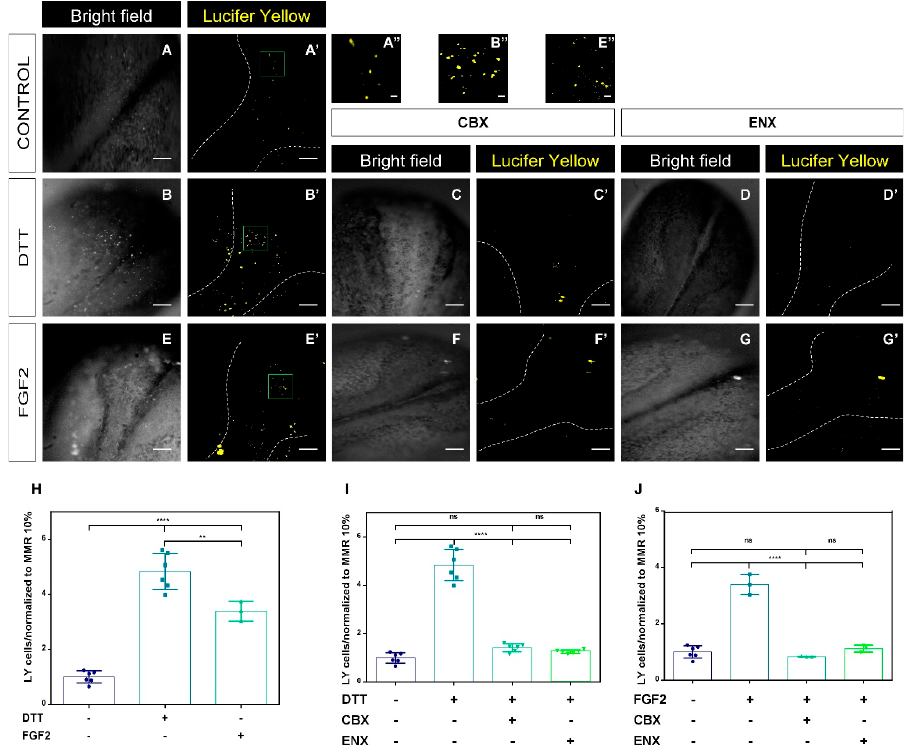
Figure 3. Lucifer Yellow uptake is modulated by FGF2 and DTT in neural plates. ( A – G ). Representa- tive images of the neural tube closure process in the control condition, DTT, DTT/CBX, DTT/ENX, FGF2, FGF2/CBX, and FGF2/ENX. ( A’ – G’ ). Neural plate cell fluorescence, illustrating LY uptake in control conditions, DTT, DTT/CBX, DTT/ENX, FGF2, FGF2/CBX, and FGF2/ENX. Scale bar: 200 μ m. The upper panel images show a magnification of the boxes in ( A’ , B’ , E’ ) signaling LY uptake, respec- tively. Scale bar ( A’’ , B’’ , E’’ ): 20 μ m. Scale bar magnified boxes: 20 μ m. ( H ). Comparison of positive LY cells under redox potential (DTT) and FGF2 conditions, quantification normalized to control condition (MMR 10%). ( I ). Quantification of LY cells after exposure to DTT. ( J ). Quantification of LY cells after exposure to FGF2. N = 3 groups of independent fertilized embryos and 5 replicates for each condition. One-way ANOVA, Bonferroní comparison test, (** = p < 0.01; **** = p < 0.0001; ns = not significant). Error bars for data represent standard deviation.